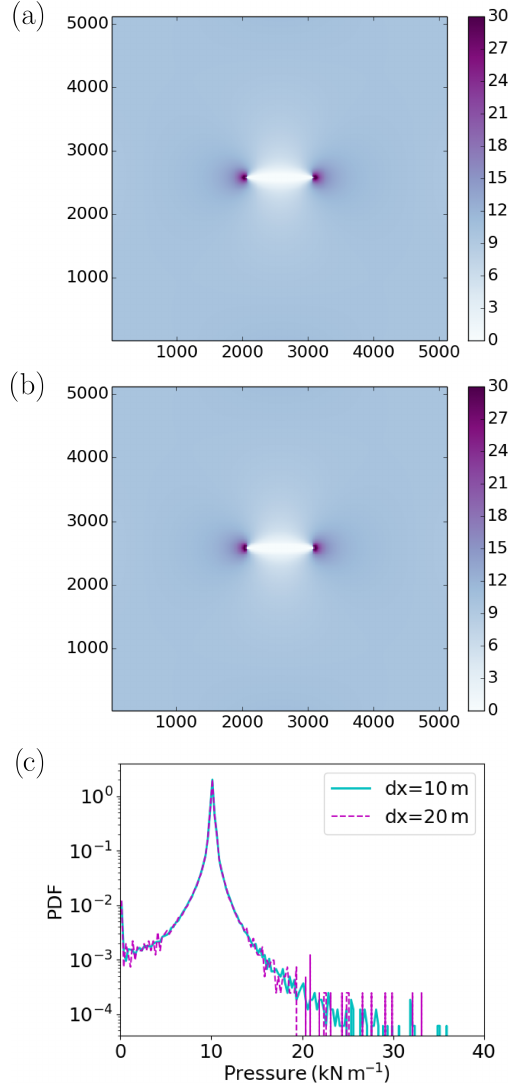
Figure 3. Pressure field for (cid:49)x = 10m (a) and (cid:49)x = 20m (b) . The thickness field is 2m everywhere except a 1km long, 40m wide hor- izontal lead in the middle of the domain. The normal stresses at the boundaries are − 10kNm − 1 . Panel (c) shows PDFs of the pressure in the 5km × 5km domain for (cid:49)x = 10m (cyan) and (cid:49)x = 20m (dashed magenta). Bins of 0.25kNm − 1 were used to build the